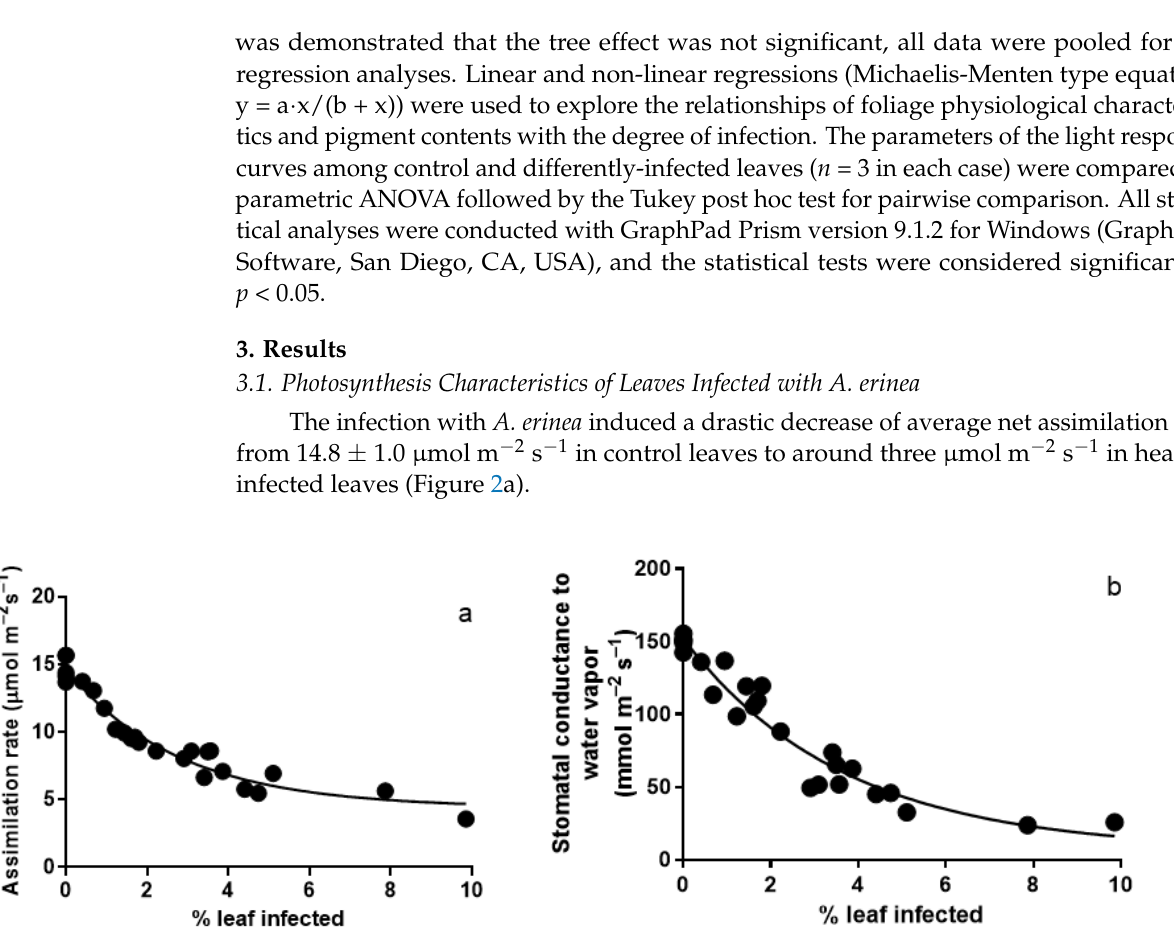
Figure 2. Leaf net CO 2 assimilation rate ( a ) and stomatal conductance to water vapor ( b ) concerning the percentage of leaf area infected with A. erinea in J. regia . Photosynthetic measurements were conducted under the following conditions: 65% chamber air humidity, 400 µ mol mol − 1 CO 2 concentration, 1000 µ mol m − 2 s − 1 incident light intensity, and leaf temperature of 25 °C ( n = 25). The data have been fitted using non-linear regression y = a x/(b + x).